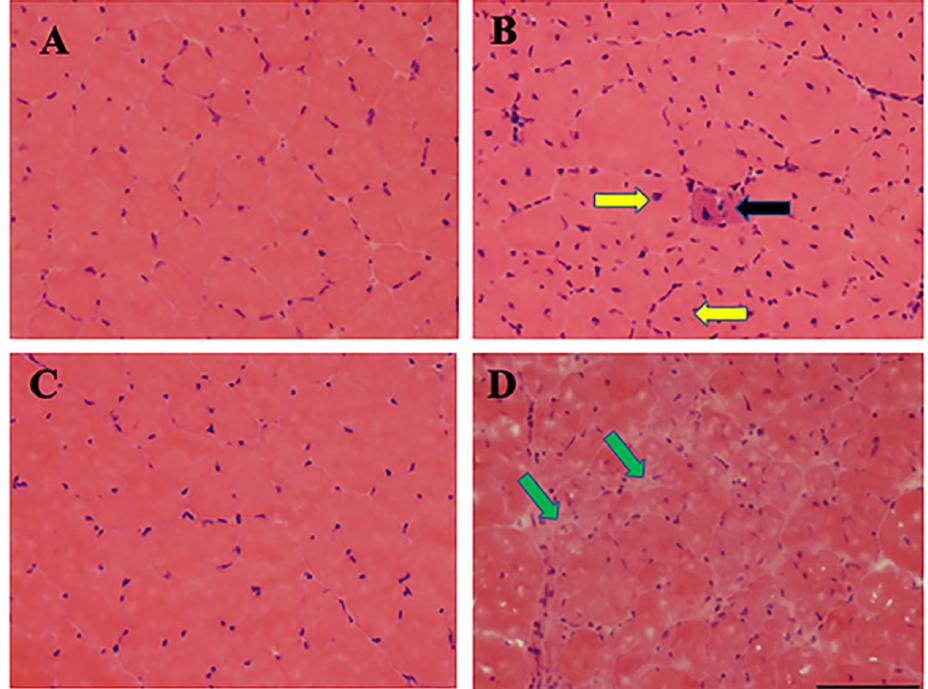
Figure 8. Skeletal muscle degenerates in mdx mouse model of DMD. Hematoxylin and Eosin (H&E) staining of Tibialis Anterior (TA) muscle sections from 3- and 12-month-old control ( A , C ) and mdx ( B , D ) mice are shown here. The 3-month old control muscle section shows normal fiber morphology including circular shape and absent central nuclei ( A ), whereas 3-month old mdx mice show muscle degeneration denoted by muscle fibers with central nuclei with smaller diameter (yellow arrows), atrophied muscle (black arrow), and more prevalent nuclei of inflammatory cells ( B ). Muscle degeneration is much more dramatic in older mdx muscle, as evident by the absence of normal muscle fiber structure and presence of fatty and necrotic tissues (green arrows). Scale bar: 100 µ M. Reprinted with permission from N. M. Ralbovsky, P. Dey, A. Galfano, B. K. Dey, and I. K. Lednev, Diagnosis of a model of Duchenne muscular dystrophy in blood serum of mdx mice using Raman hyperspectroscopy, Scientific Reports, 10, 11734, Copyright (2020) Springer Nature.